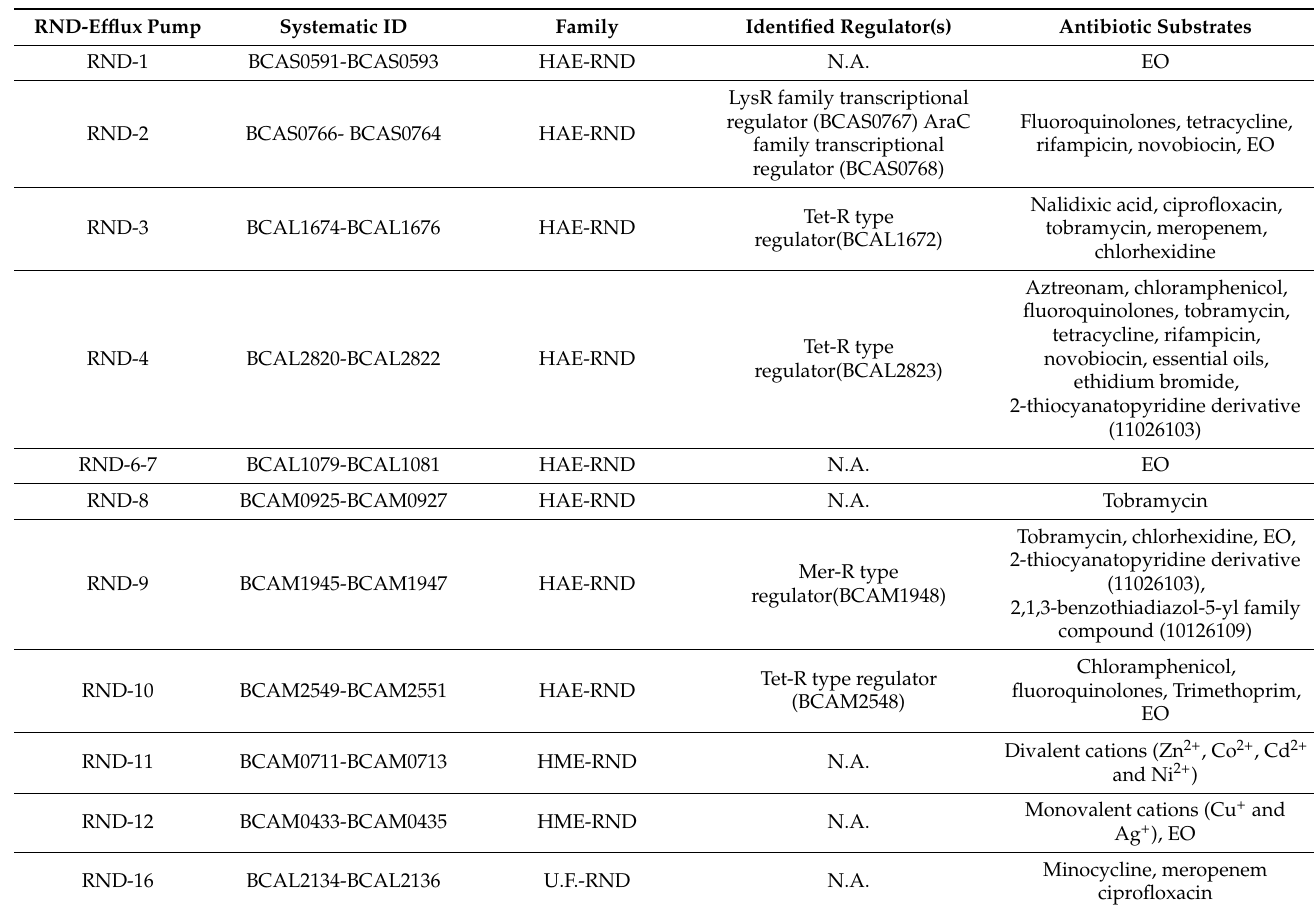
Table 2. RND efflux pumps in B. cenocepacia